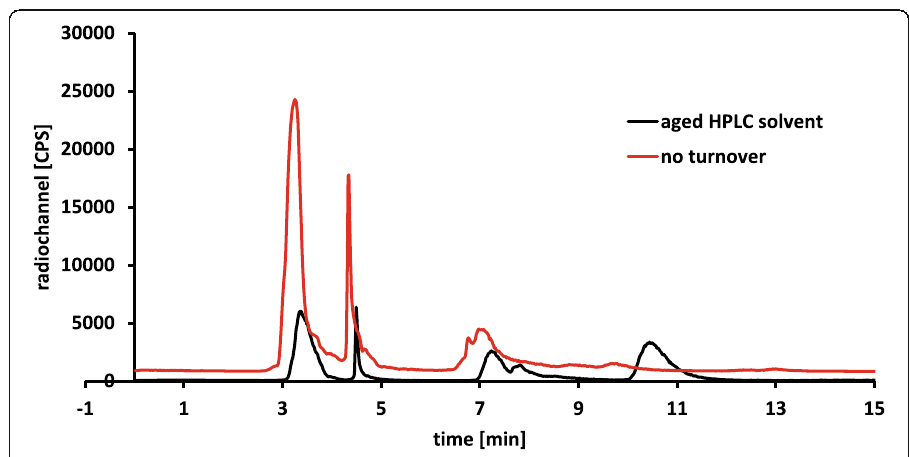
Fig. 9 Insufficient semi-preparative RP-HPLC chromatograms caused by aged HPLC solvent (black) or decomposed butanone